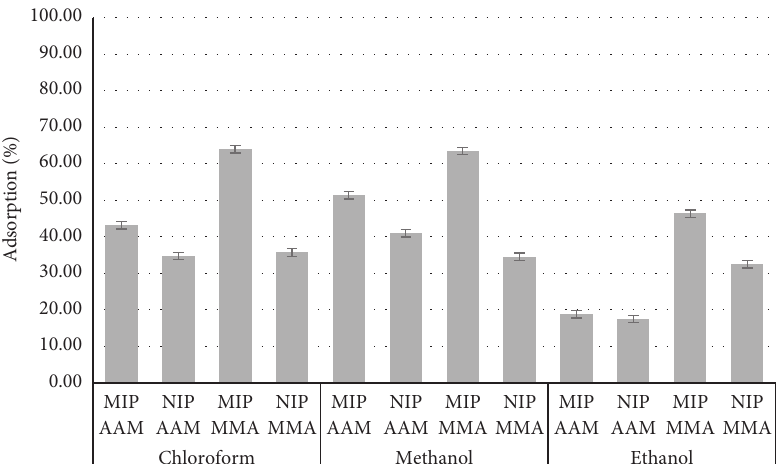
Figure 2: Adsorption percentage of MIP and NIP in chloroform, methanol, and ethanol. The error bars represent the standard deviation of three separate sample runs ( n �